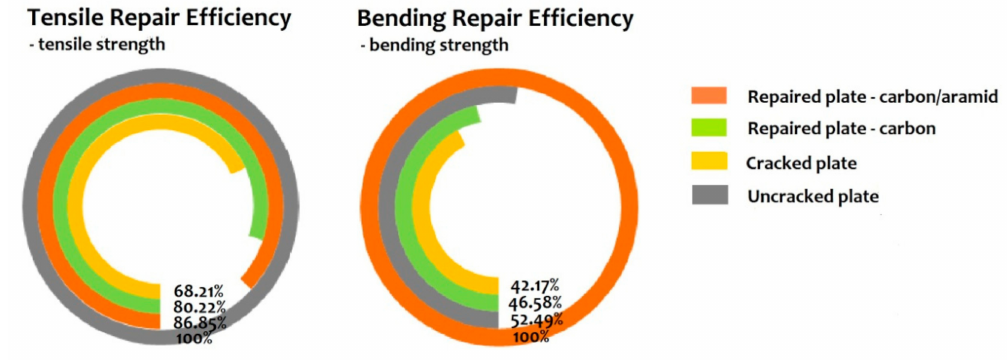
Figure 6. Pie charts of tensile and bending strength repair e ffi ciency of the cracked plate repaired by the 3-layer sandwich